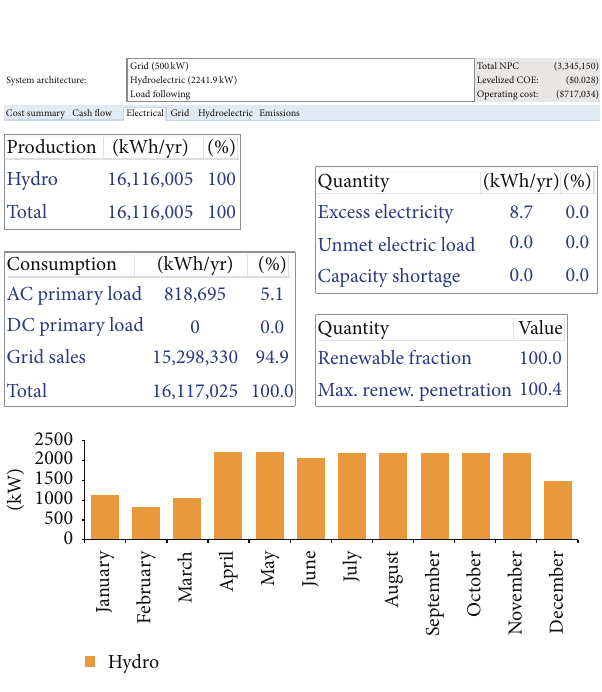
Figure 17: Electrical output.